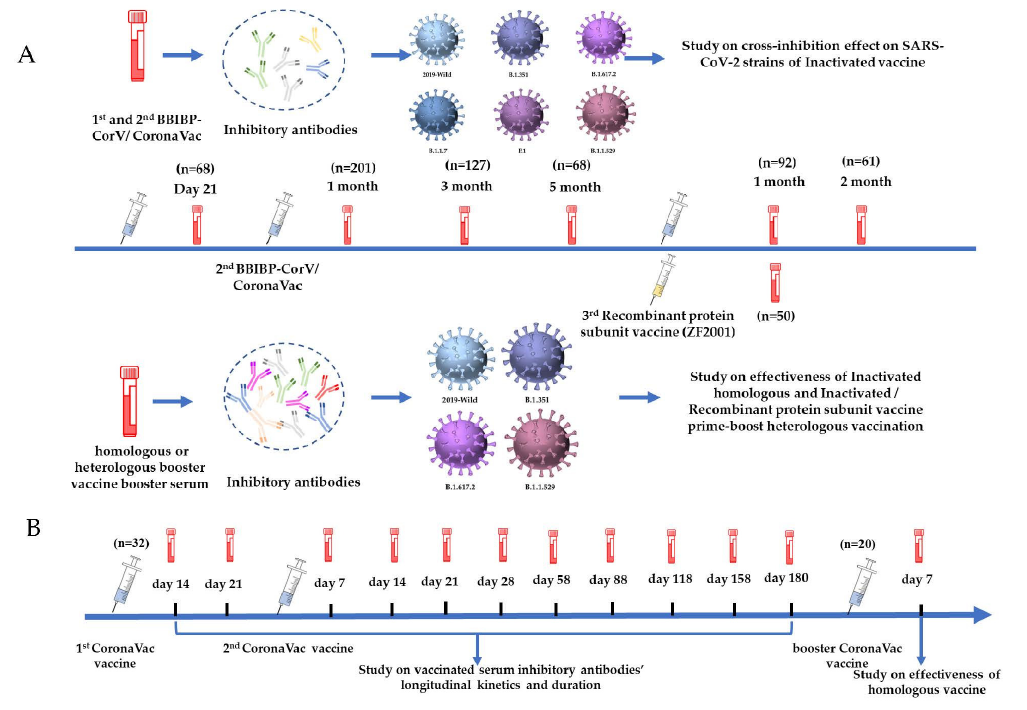
Figure 1. Collection of vaccine serum samples and study of antibody vaccine-induced effectiveness on SARS-CoV-2 strains. ( A ) Evaluation antibodies of serum samples collected at the 4 time points: the 3rd week (n = 68) following the first inactivated vaccination dose and the 1st month (n = 201), 3rd month (n = 127), and 5th month (n = 68) following the second dose of inactivated vaccine (CoronaVac/BBIBP-CorV) and serum samples from the first (n = 92) and second months (n = 61) after a homologous booster and from the first month (n = 50) following recombinant protein subunit vaccine (ZF2001) as a heterologous booster. ( B ) Evaluation of serum sample antibodies from 32 individuals who received two complete doses of CoronaVac at 10 time points.